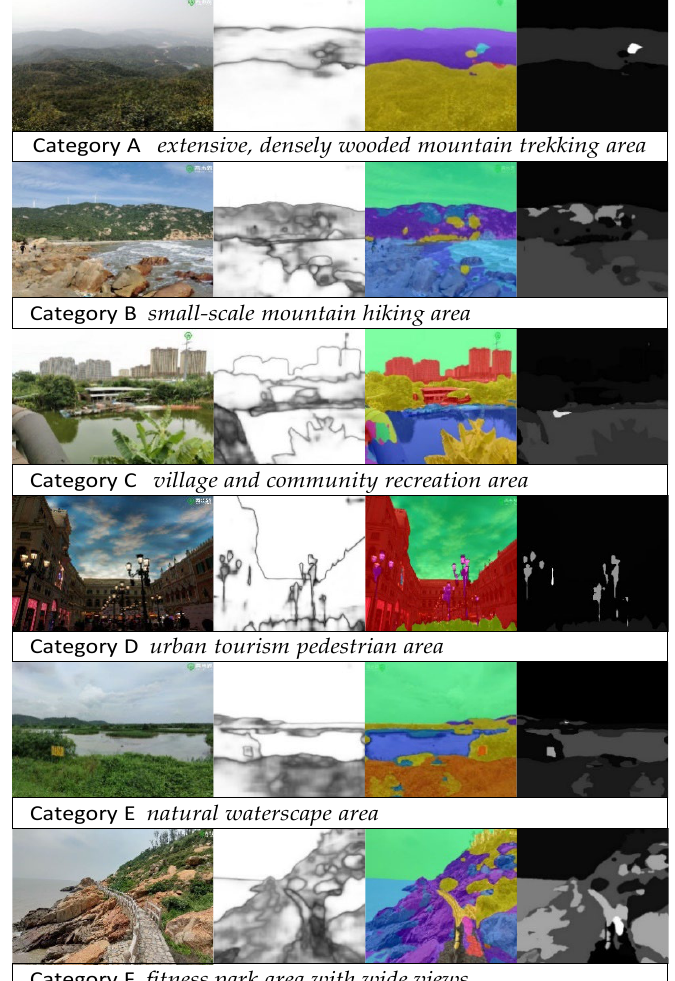
Figure 8. Example landscapes from categories A–F.